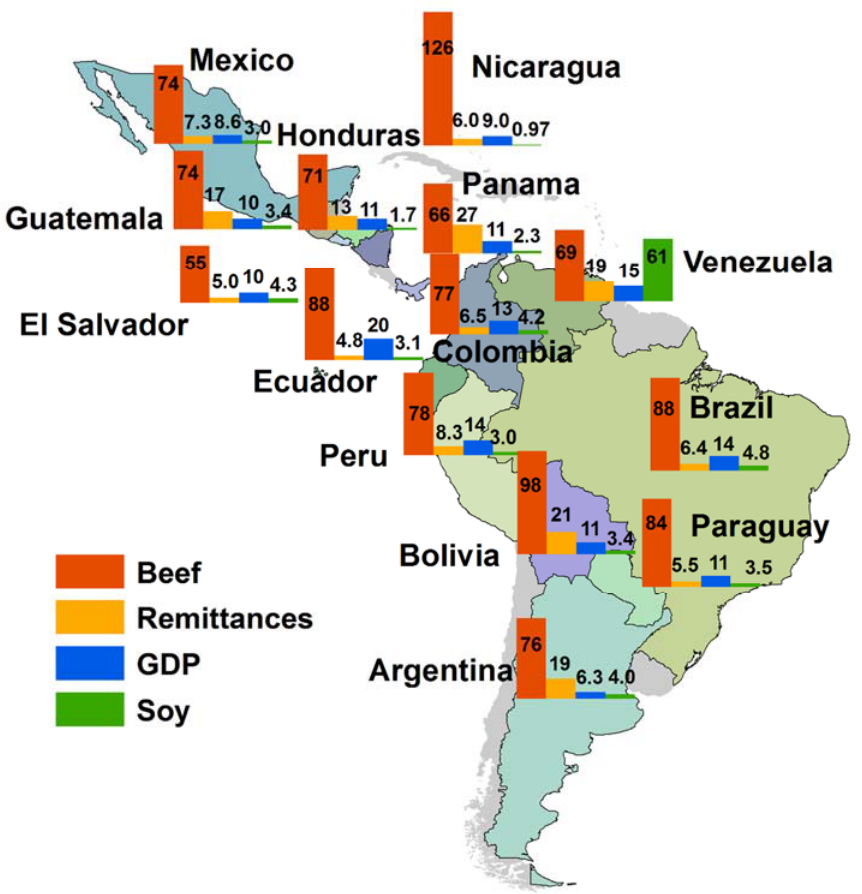
Figure 2. The four largest national level predictors of municipal-level deforestation in LAC (2001– 2010).